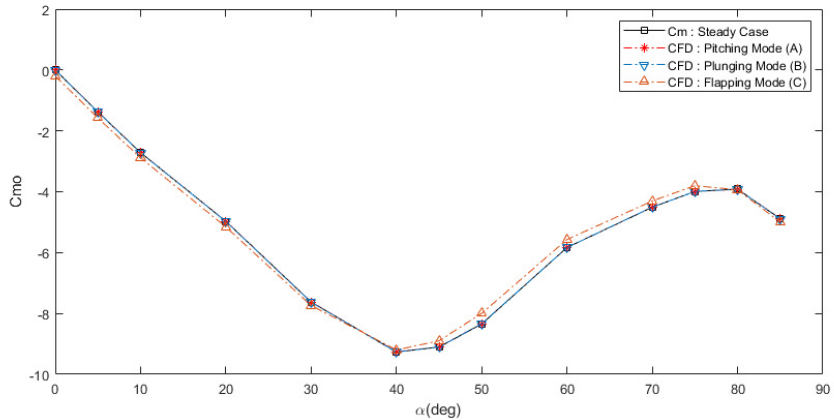
Figure 18. Comparison of 𝐶 (cid:3040)